Question: Looking at the figure, what chart type is it?
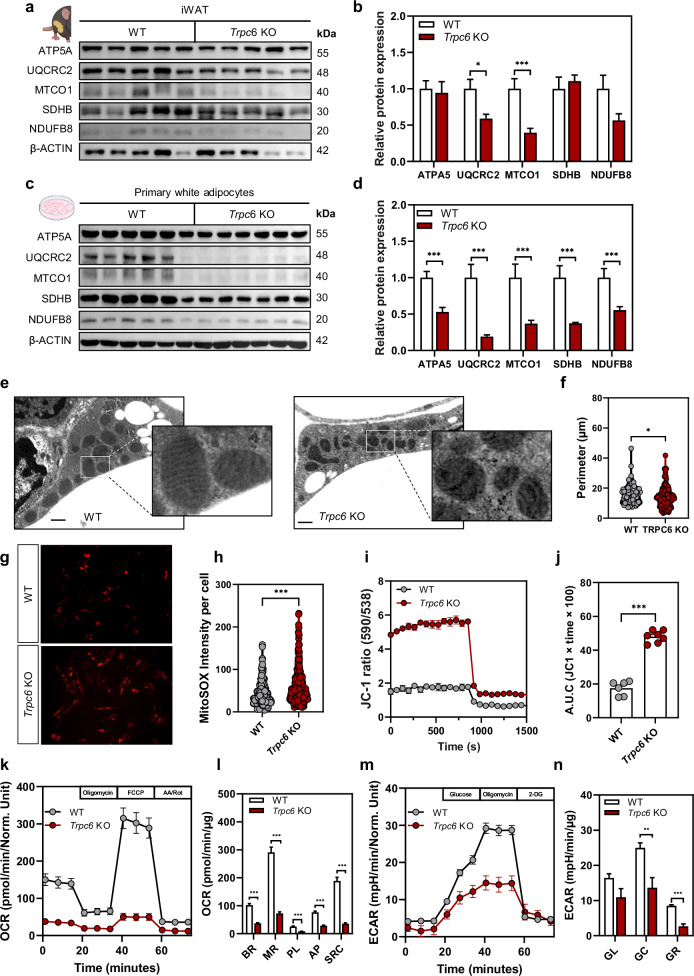
Answer: bar